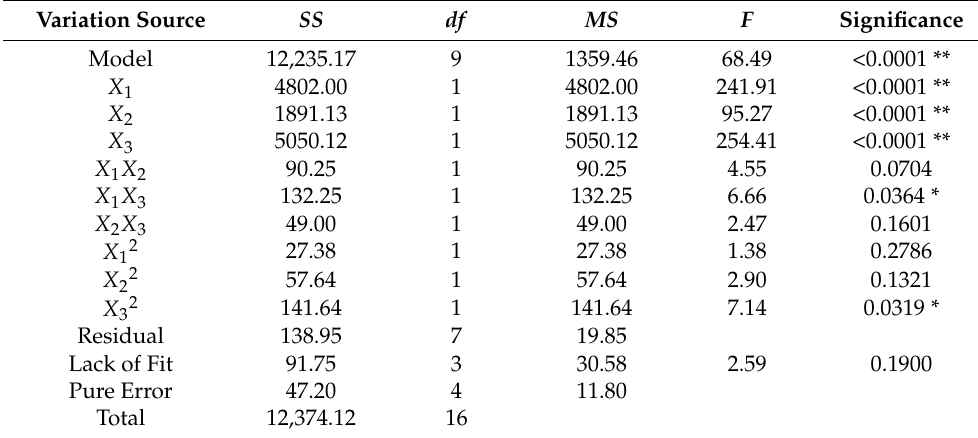
Table 11. Variance analysis table of scouring